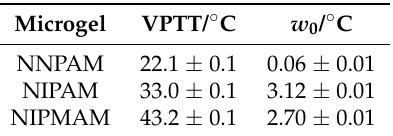
Table 4. Volume phase transition temperatures of the homopolymer microgels obtained by turbidity